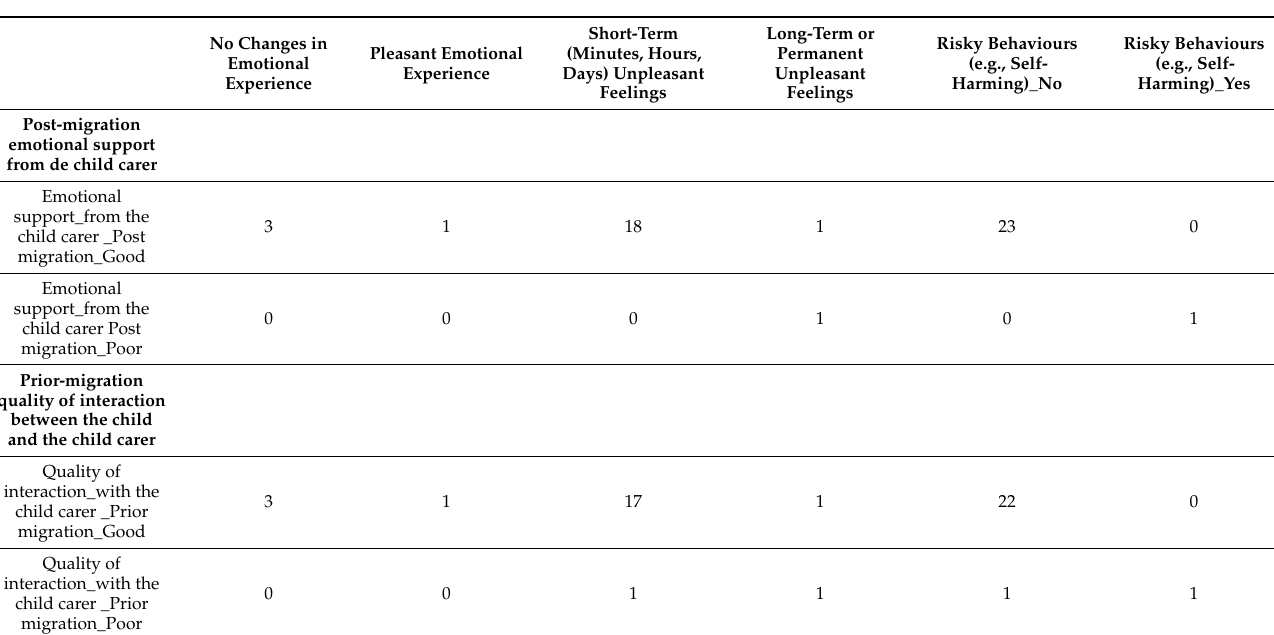
Table A3. Changes on children by emotional support provision by child